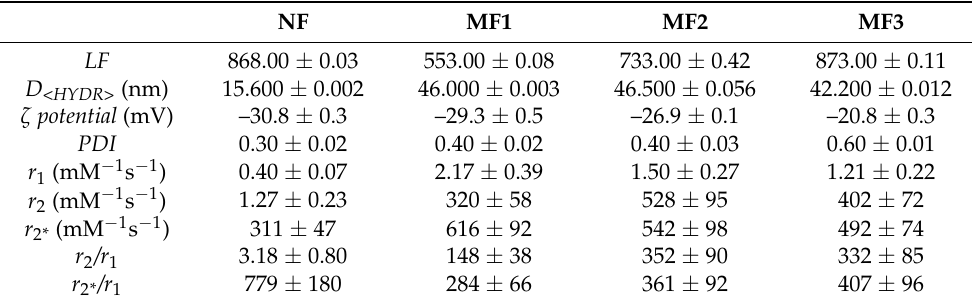
Table 1. The physico-chemical properties and relaxivity values of NF and MF: (i) loading factor ( LF); (ii) hydrodynamic diameter ( D <HYDR> ); (iii) ζ potential ; (iv) polydispersity index ( PDI ); (v) longitudi- nal relaxivity r 1 ; (vi) transverse (“true”) relaxivity r 2 ; (vii) transverse (“observed”) relaxivity r 2 * ; (viii) relaxivity ratio r 2 /r 1 ; (ix) relaxivity ratio r 2 * /r 1